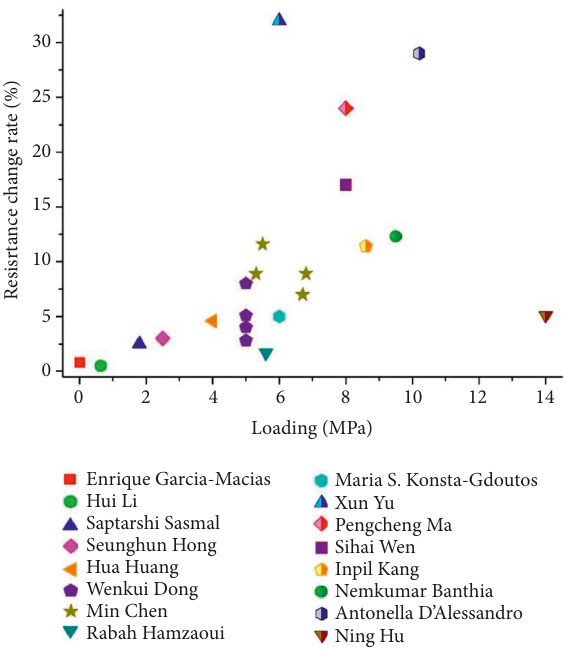
Piezoresistive characteristics of smart